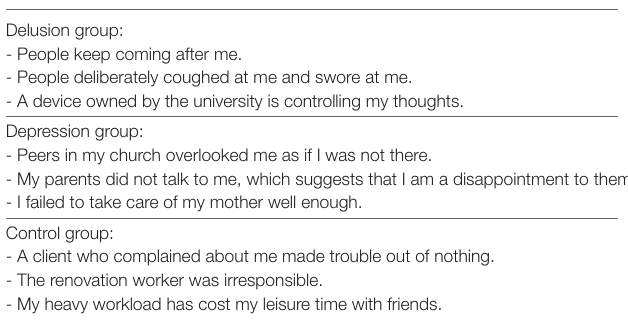
TABLE 1 | Examples of idiosyncratic beliefs elicited for the assessment of belief flexibility (MADS). Delusion group: - People keep coming after